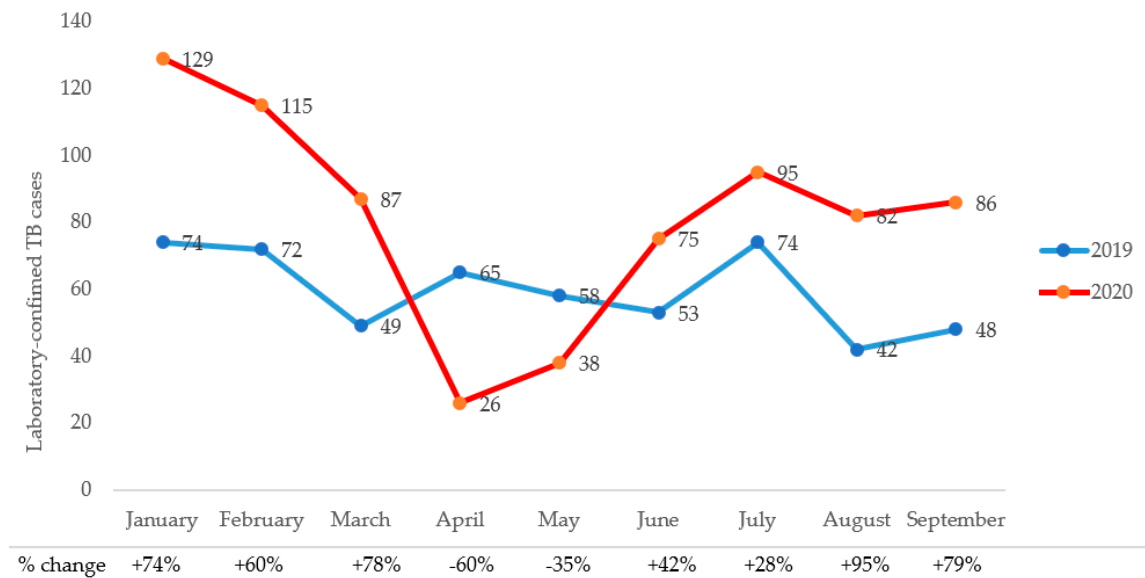
Figure 2. Trends in monthly presumptive TB cases during the pre- and intra-COVID-19 periods.